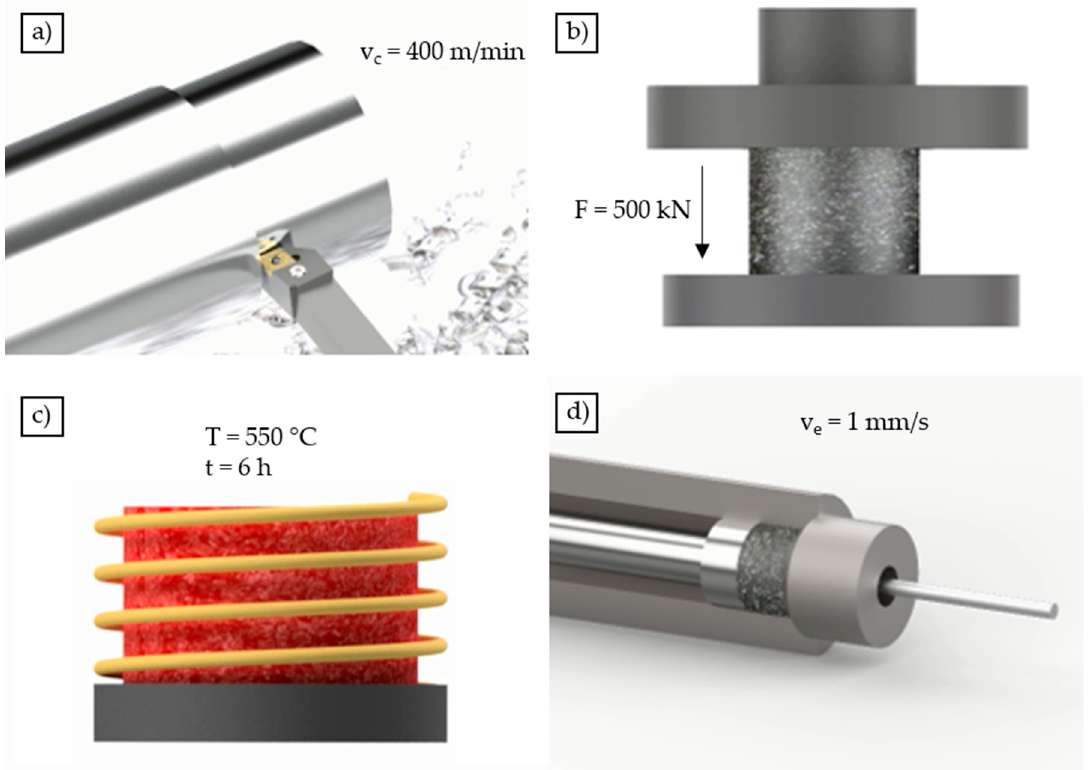
Figure 1. Schematic representation of the extrusion process steps: Machining of the chips ( a ), pre-compaction ( b ), heat treatment ( c ), hot extrusion ( d ).